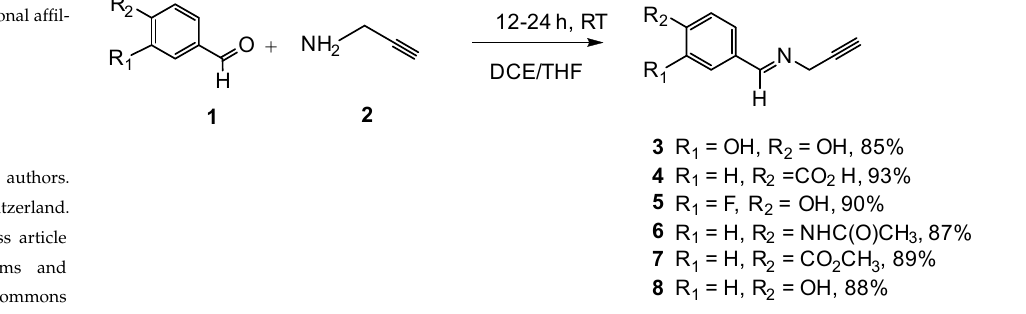
Scheme 1. Preparation of propargyl imines from propargyl amine.